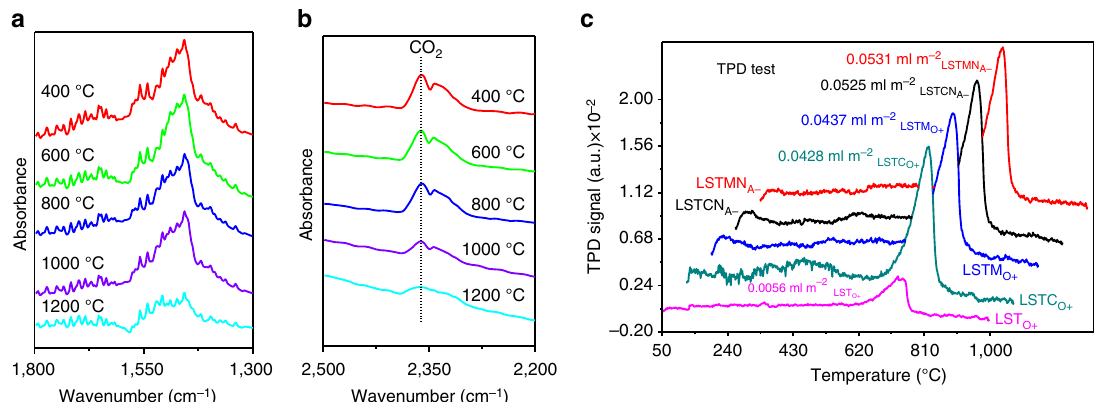
Figure 3 | Chemical adsorption of CO 2 for a series of samples. ( a , b ) In situ infrared spectroscopy of CO 2 adsorbed on the reduced LSTMN A (cid:2) from 400 to 1,200 (cid:2) C; ( c ) Temperature Programmed Desorption (TPD) test of CO 2 on the reduced samples from 50 to 1,000 (cid:2) C in pure CO 2 .